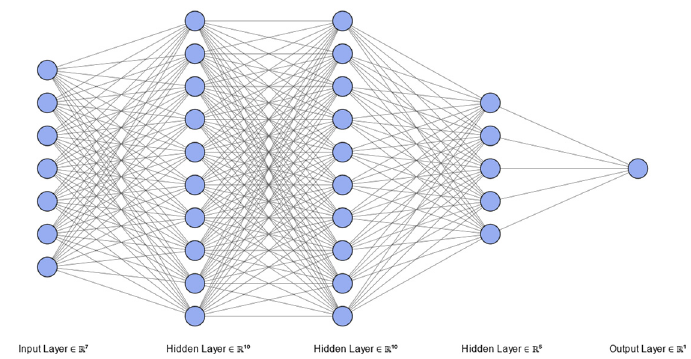
Figure 3. The network architecture of deep learning in the